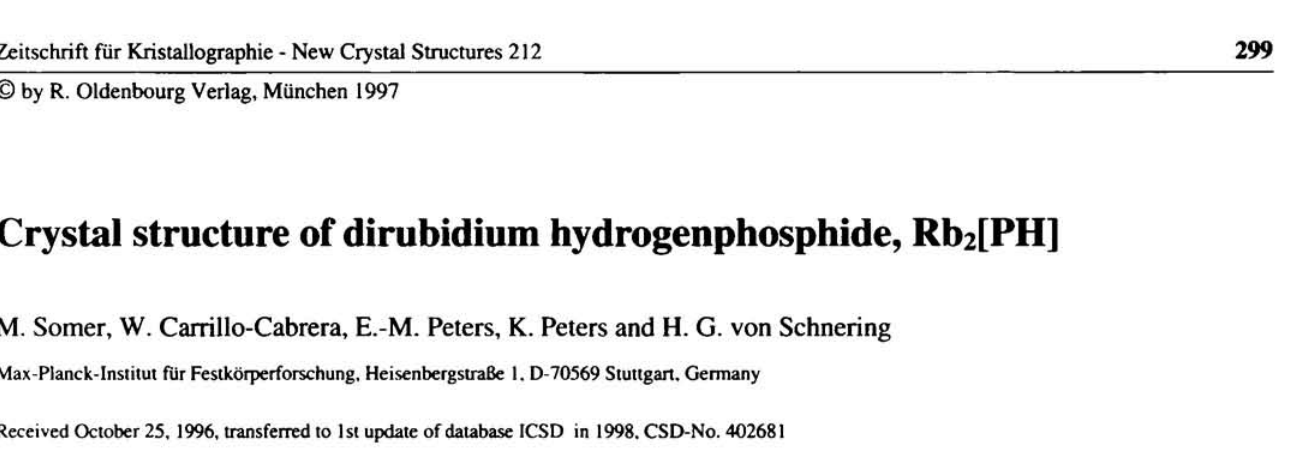
Rb2 [PH] crystallizes in the C02P type (see ref. 1). The [PH] 2 anions center the tricapped trigonal prisms built up by the Rb atoms. It was not possible to determine the position of the Η atoms. However, the IR spectra of a single crystal as well as of a powdered sample exbit the characteristic P-H absorption at V (P-H) = 2122 cm" .